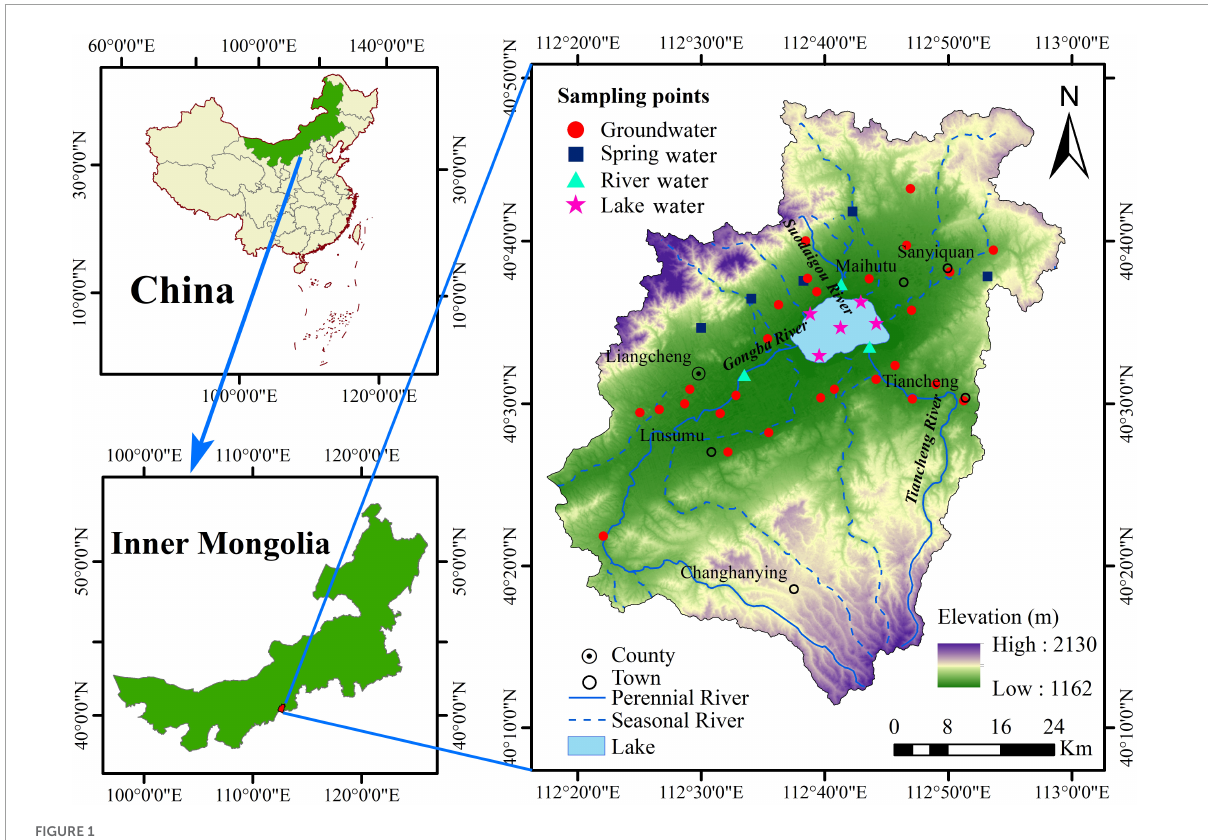
FIGURE1 Geographical location and sampling points of the Daihai Lake